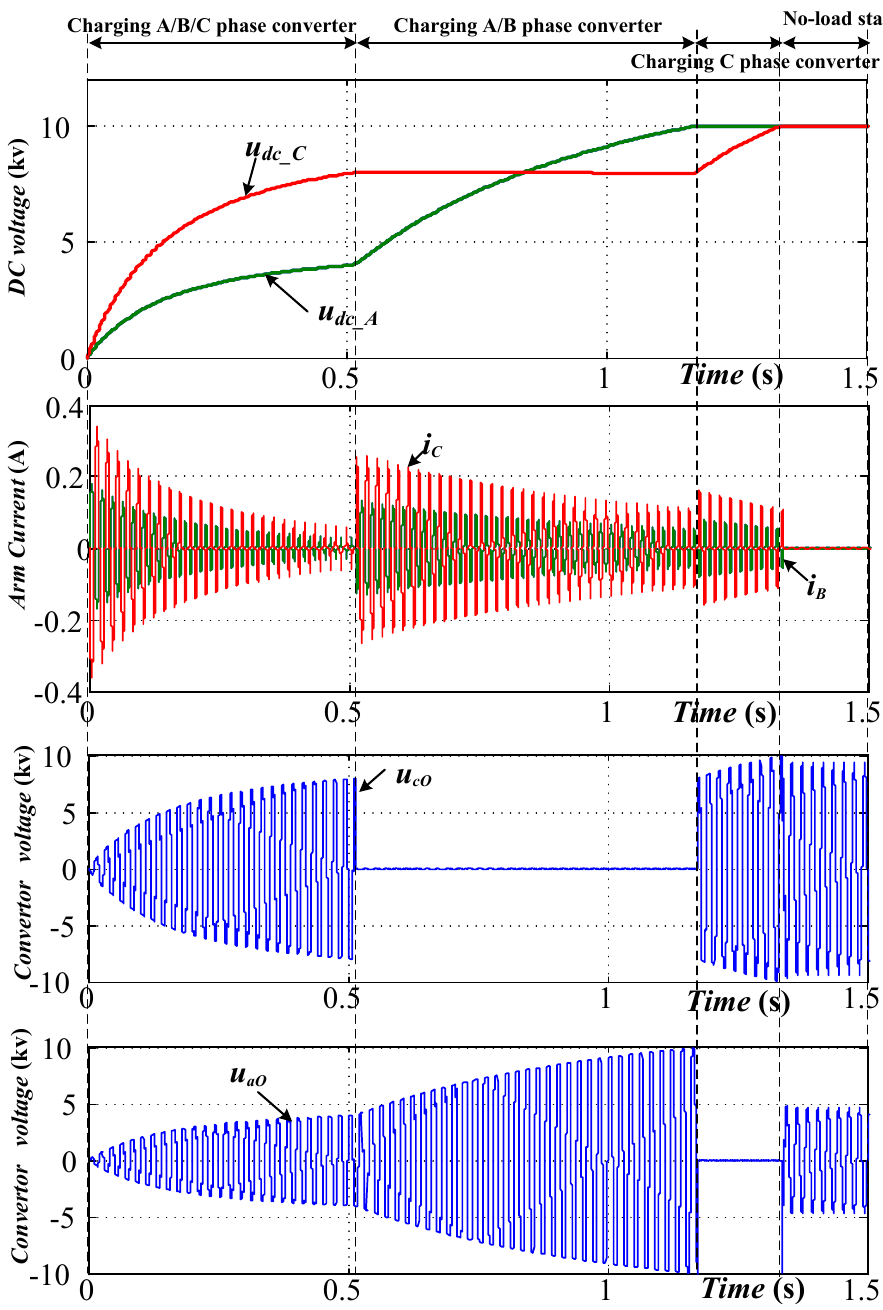
Figure 7. Simulation results of the proposed soft power-on process.